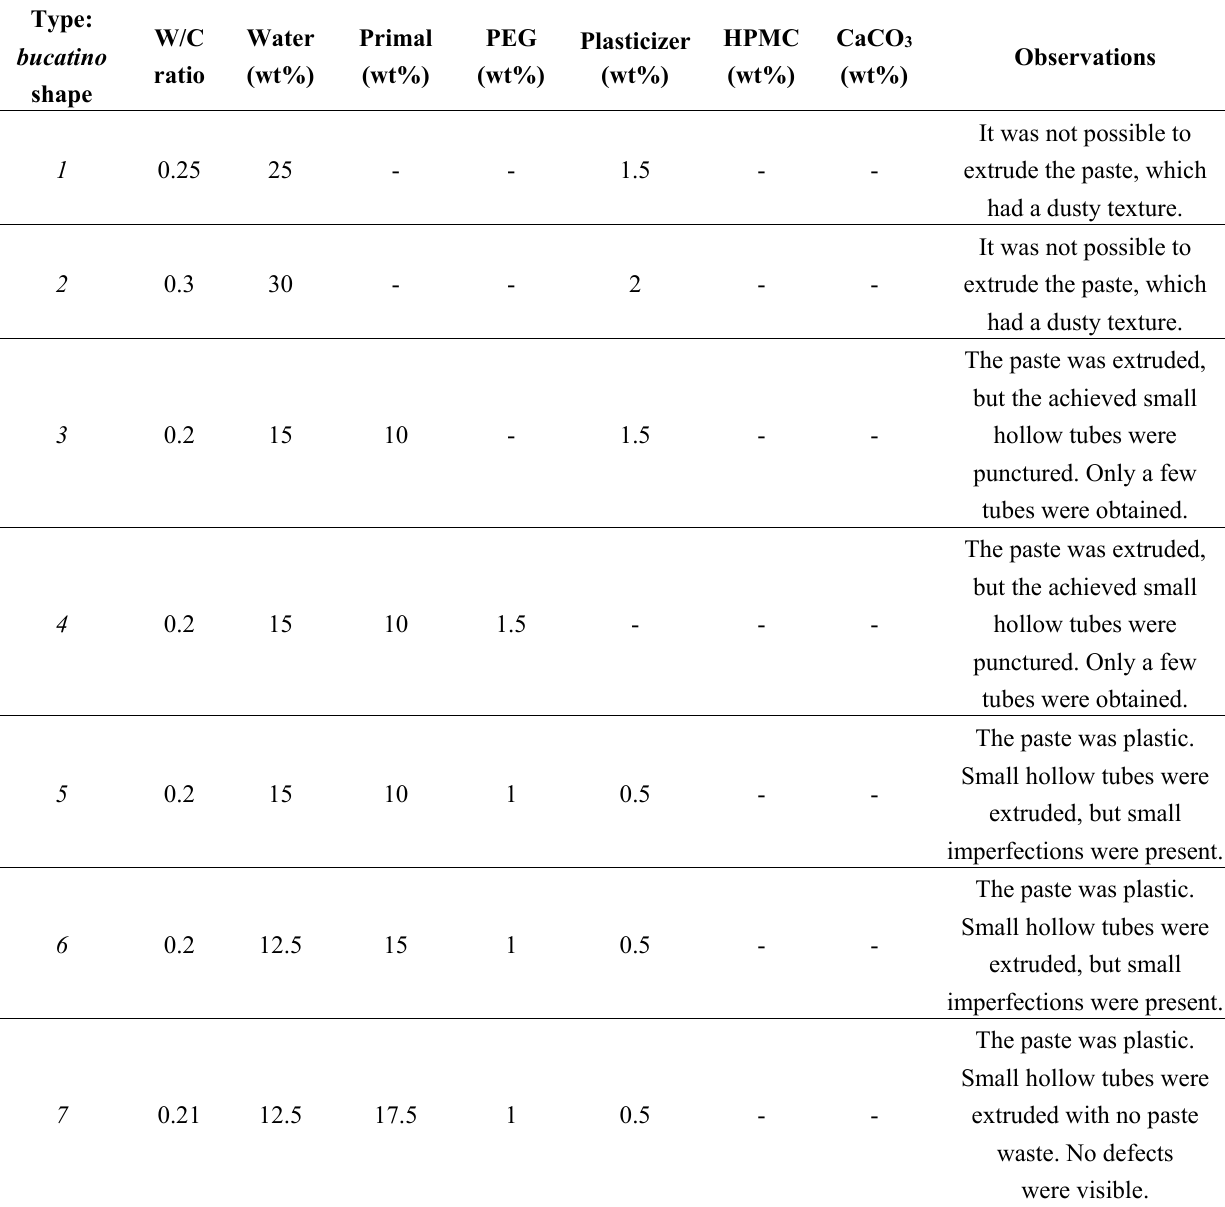
Table 1. Composition details for the extrusion of cementitious hollow tubes with a bucatini shape (proportions with respect to cement). HPMC, hydroxypropyl